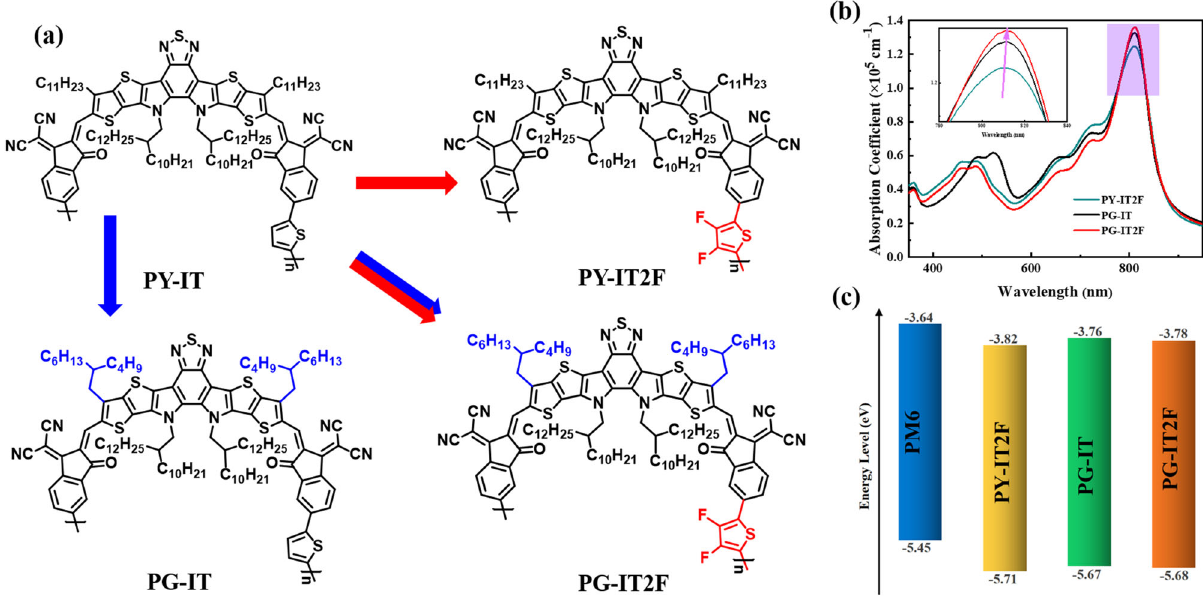
Fig. 1 | Molecular structures and physicochemical properties of PSMAs. a Molecularstructures (blue color alkylchains are the branchedupper side chains, and red color di fl uorothiophene is the modi fi edlinking unit) ofPY-IT,PY-IT2F,PG-